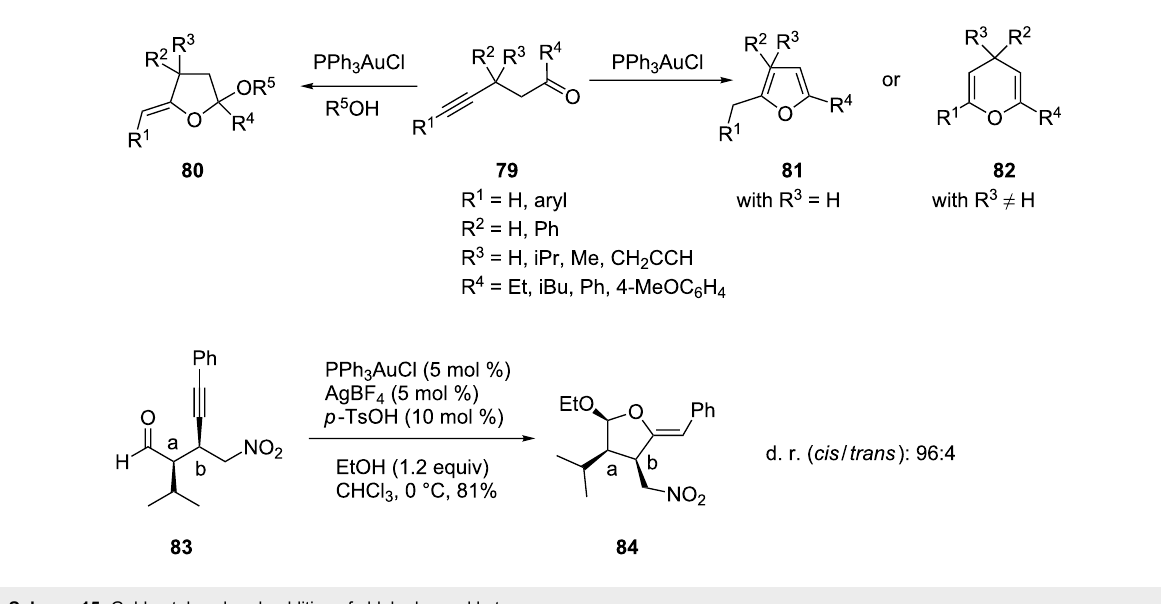
Scheme 15: Gold-catalyzed cycloaddition of aldehydes and